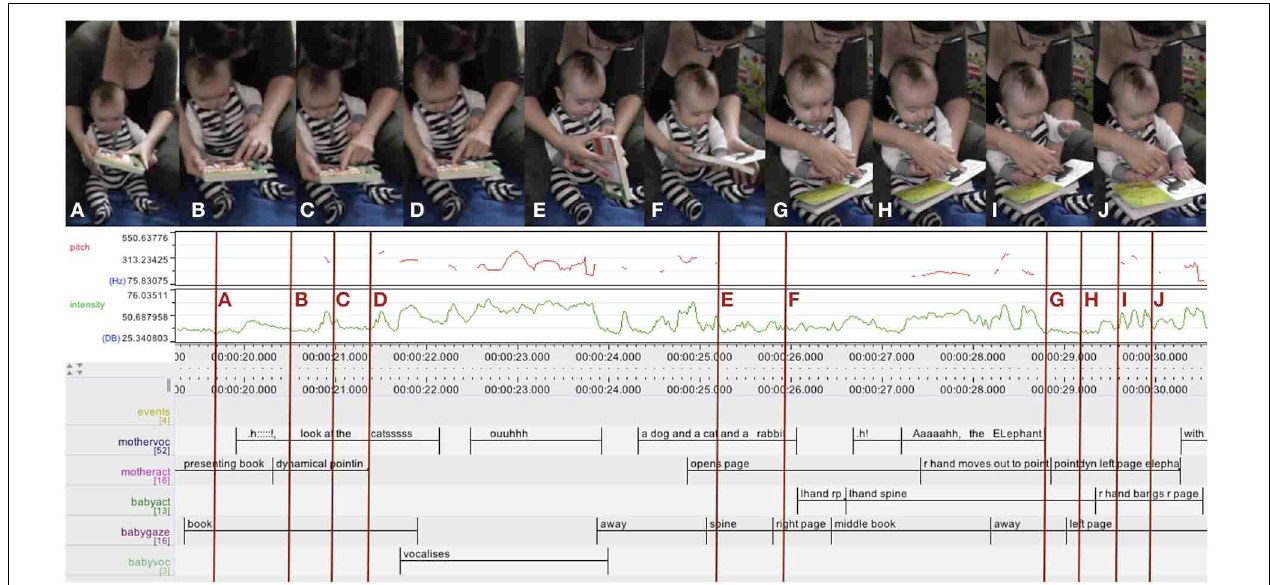
FIGURE 3 | Mother multimodally presenting a book, holding it within reach of her infant: Introducing the book to the infant (A), marking the animals on the title page by dynamical pointing and vocal labeling (B–D), opening the book with the infant attending (E,F), more dynamical pointing drawing the infant’s attention (G,H), who subsequently acts on